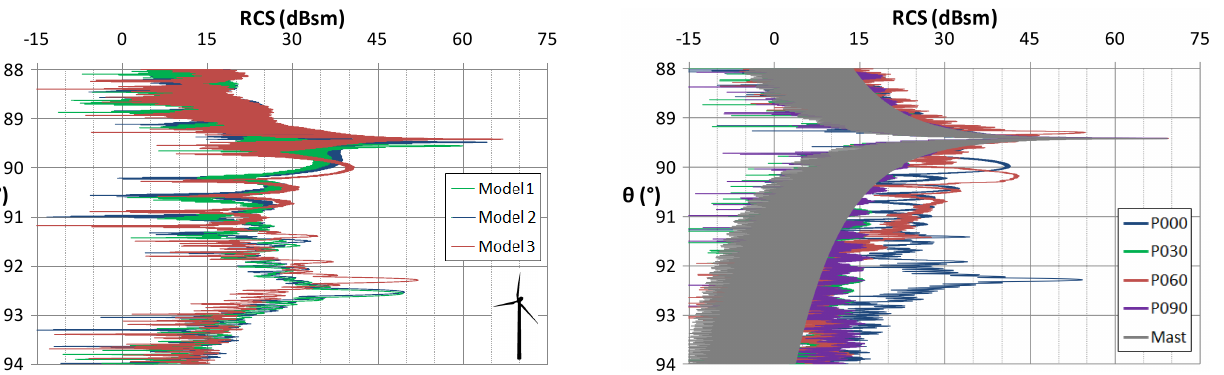
Figure 5. Vertical sections of RCS patterns ( φ = 5 ◦ ) for wind tur- bine model 3 at frequency 9.40GHz. Legend entries starting with PXXX indicate the position of the upper blade (being P000 vertical right position and P090 horizontal position).